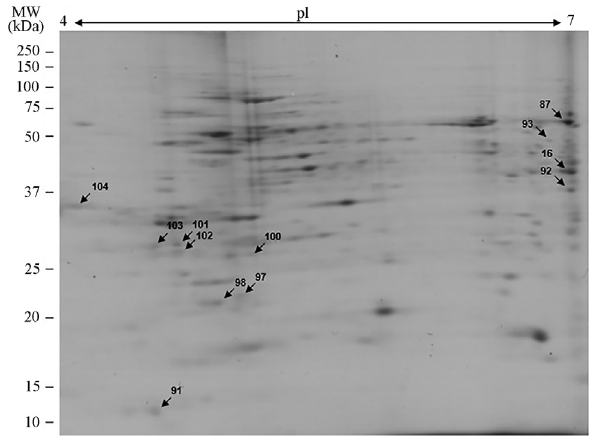
Figure 1 - Representative 2D protein gel obtained for E. urograndis stems. Protein spots selected for mass spectrometry-based identification are marked with an arrow and number, as in Table 1. Molecular mass markers are indicated to the left of the gel.